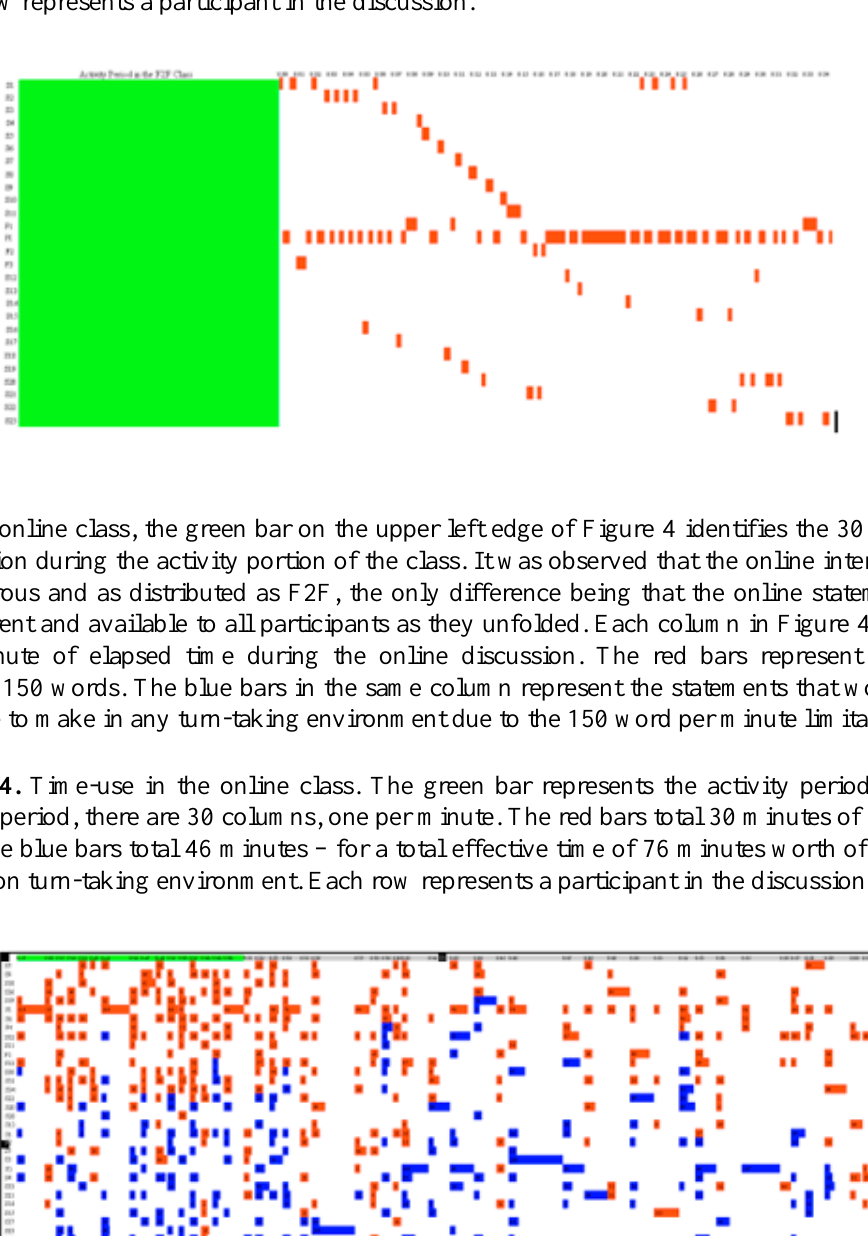
Figure 3. Time-use in the turn-taking, face-to-faceF2F class. The activity portion is in green. The processing period is after the green. The red bars total 30minutes in the turn-taking, face-to- faceF2F interaction. The scale is expanded in this region so the red bars are proportional to time. Each row represents a participant in the discussion.